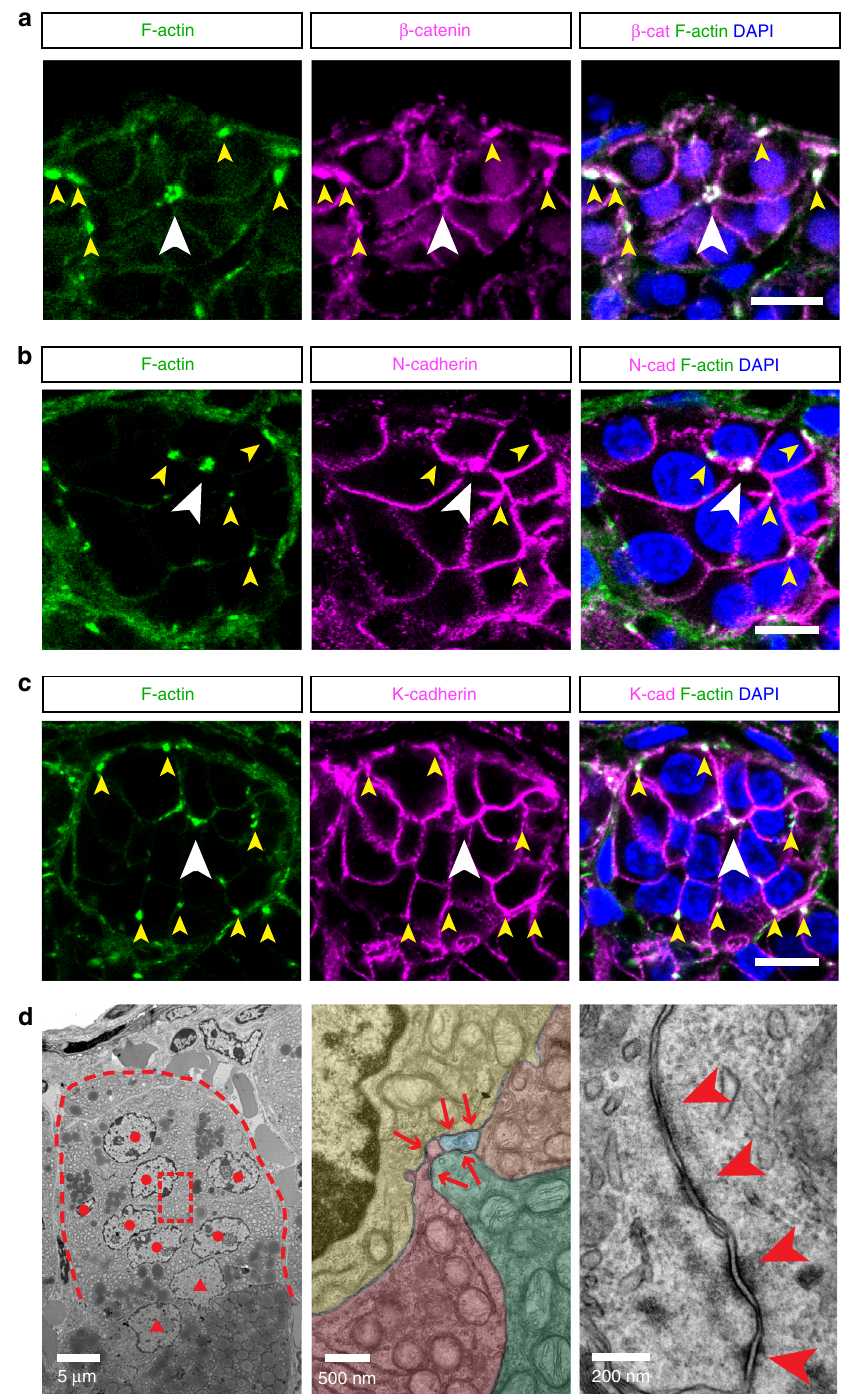
Fig. 2 Adherens junction components are enriched at rosette centers. a – c Colocalization of F-actin (green) and β -catenin ( β -cat, magenta), N-cadherin (N-cad, magenta), and K-cadherin (K-cad, magenta) at rosette centers (white arrowheads) and smaller F-actin punctae (yellow arrowheads). DAPI (blue) marks nuclei. All bars, 10 μ m. d Transmission electron micrographs showing adherens junctions in the zG. Left, red dashed line marks the boundary of a glomerulus. Red dots denote nuclei of zG cells. Red triangles denote nuclei of zF cells. Boxed area is shown at a higher magni fi cation in the middle panel where individual cells are pseudo-colored. Red arrows point to adherens junctions. Right, an example of aggregating adherens junctions (red arrowheads). Bar sizes are indicated in each